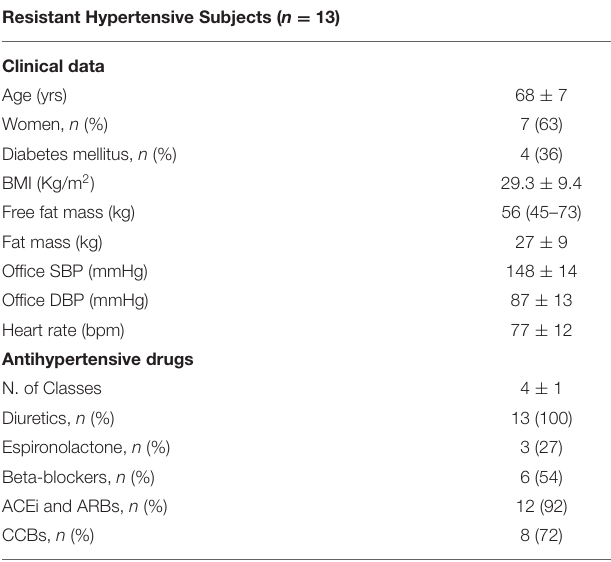
TABLE 1 | Characteristics of patients enrolled in acute and short-term protocols. Resistant Hypertensive Subjects ( n =